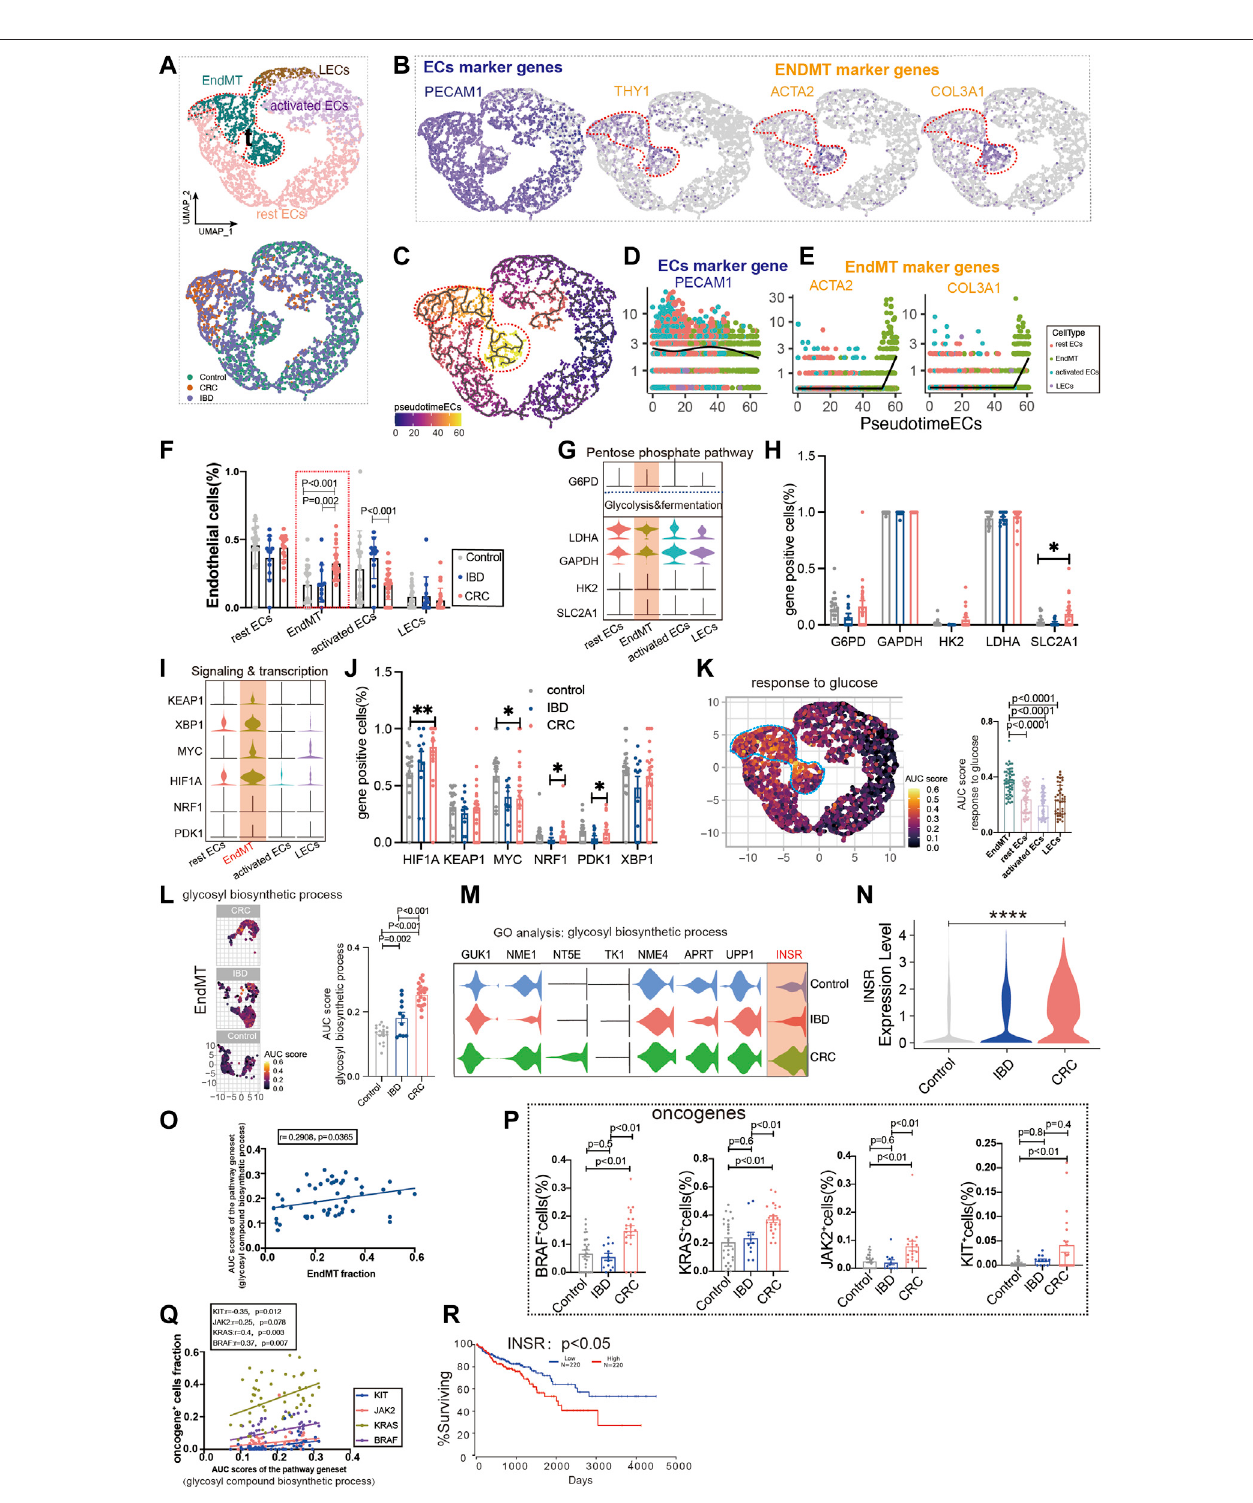
FIGURE 4 | Glucose metabolic status of EndMT in IBD and colon cancer. (A) UMAP of 5,356 intestinal ECs from 26 control samples, 12 in fl ammatory bowel disease(IBD),22colorectal cancer(CRC). Eachdotrepresents asinglecell,andcellsarelabeledbycelltype. UMAPdemonstratesthecellularsubpopulationsofthegut ECs, including EndMT, activated ECs, rest ECs, and lymphatic ECs. (See also Supplementary Table S2, S3 ). (B) UMAP plots showing EC-speci fi c marker genes ( PECAM1 ) and EndMT marker genes ( THY1 , ACTA2 , and COL3A1 ). (C) Pseudo-temporal analysis shows the evolutionary trend of ECs as “ rest EC-activated EC- EndMT. ” (D, E) Temporal variation of EC marker genes ( PECAM1 ) and EndMT marker genes ( THY1 , ACTA2 , and COL3A1 ). (F) Cell proportions of each cell